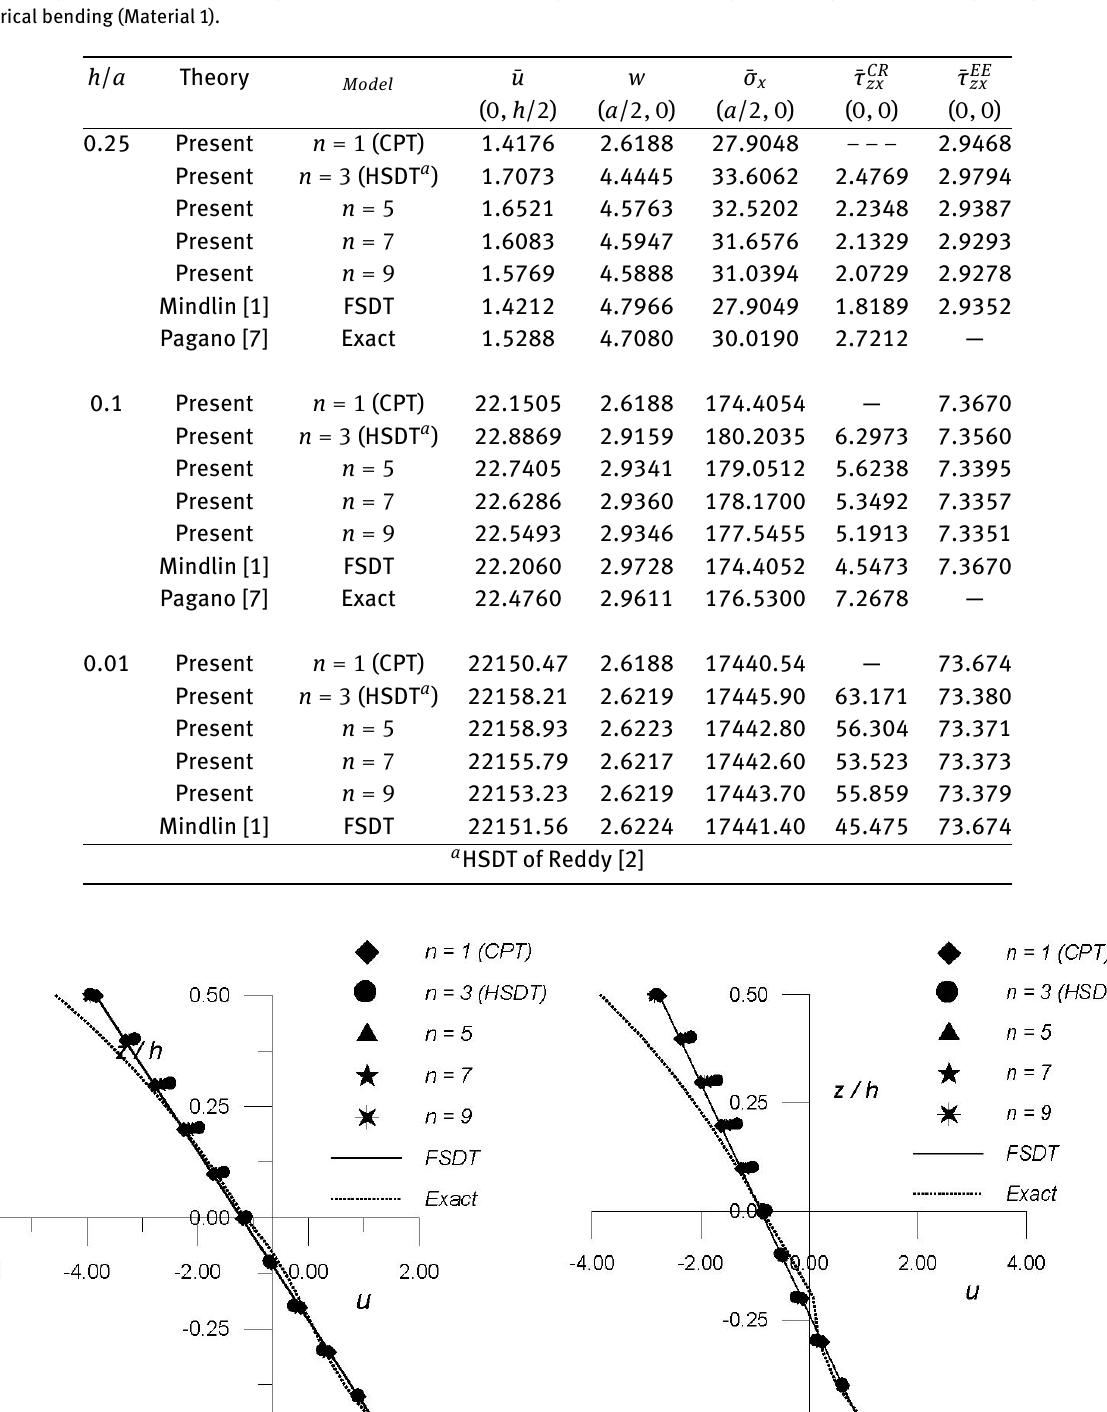
Figure 3: Through thickness distribution of in-plane displacement ( ¯ u ) for simply supported two layered (0 ∘ /90 ∘ ) un-symmetrically laminated composite plates with a / h = 4 and E 1 / E 2 = 25